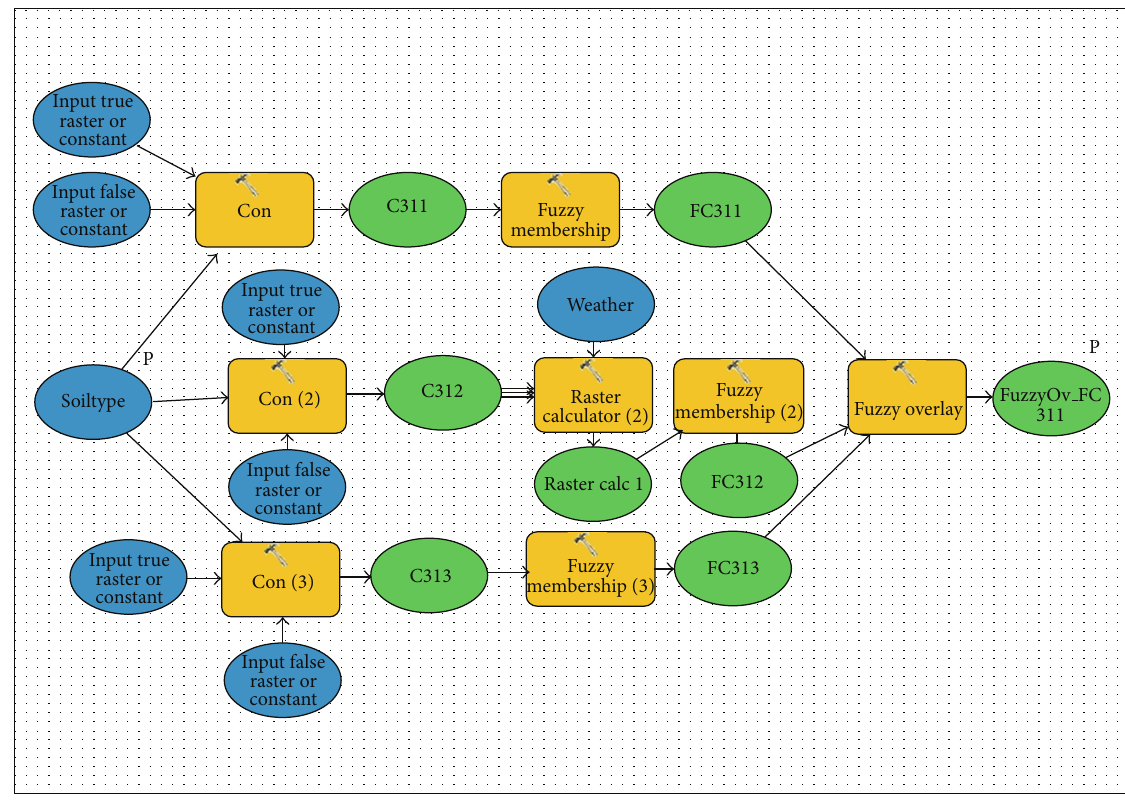
Figure 7: Demonstration of a model for calculation of deceleration coefficient created in the environment of ModelBuilder